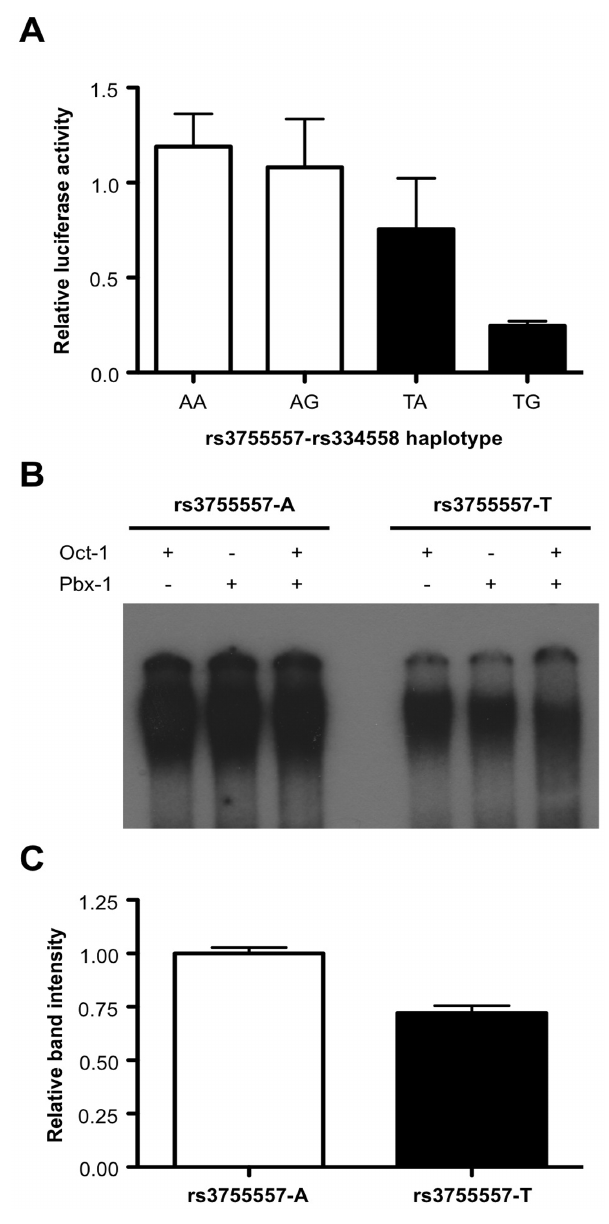
Figure 1. Effect of GSK3B rs3755557 on transcription. a) Comparison of expression levels from GSK3B promoter constructs by luciferase reporter gene assay. Constructs contained either the A or T allele of rs3755557 on a background of either the T or C allele of rs334558. Error bars indicate standard error of the mean from 3 independent experiments. *, p , 0.05. b) Electrophoretic mobility shift assay to show differential binding of either Oct-1 or Pbx-1 transcription factors to labeled oligomers corresponding to either the A or T allele of rs3755557. c) Quantification of gel shift assay. Error bars indicate standard error of the mean density of bands corresponding to (Oct-1), (Pbx-1) and (Oct-1 + Pbx-1) binding for each allele.